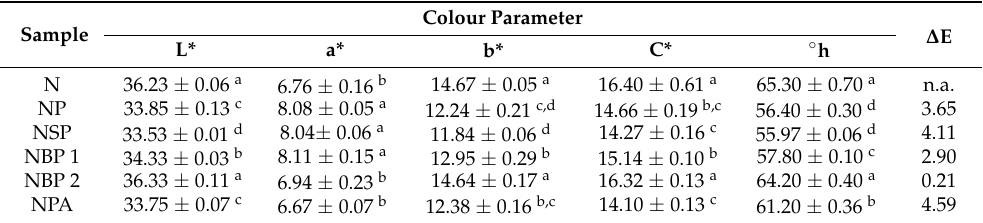
Table 4. Colour parameters (L*, a*, b*, C*, ◦ h) and total colour change ( ∆ E) of different